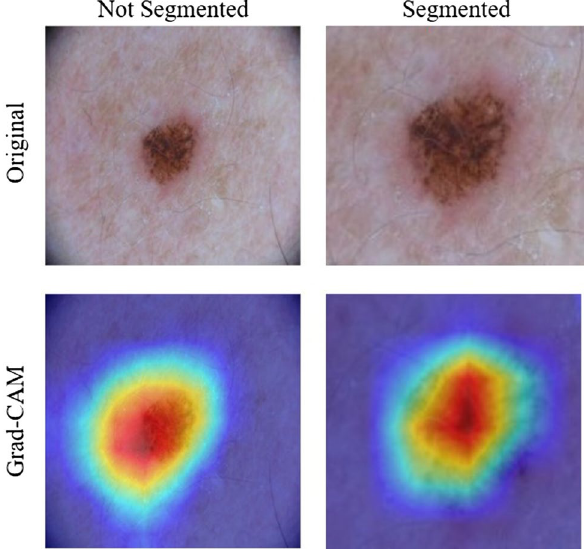
Figure 4. Grad-CAM results for unsegmented and segmented images in the ISIC2017 dataset. For both images of Grad-CAM, the EfficientNet model correctly focused mostly on